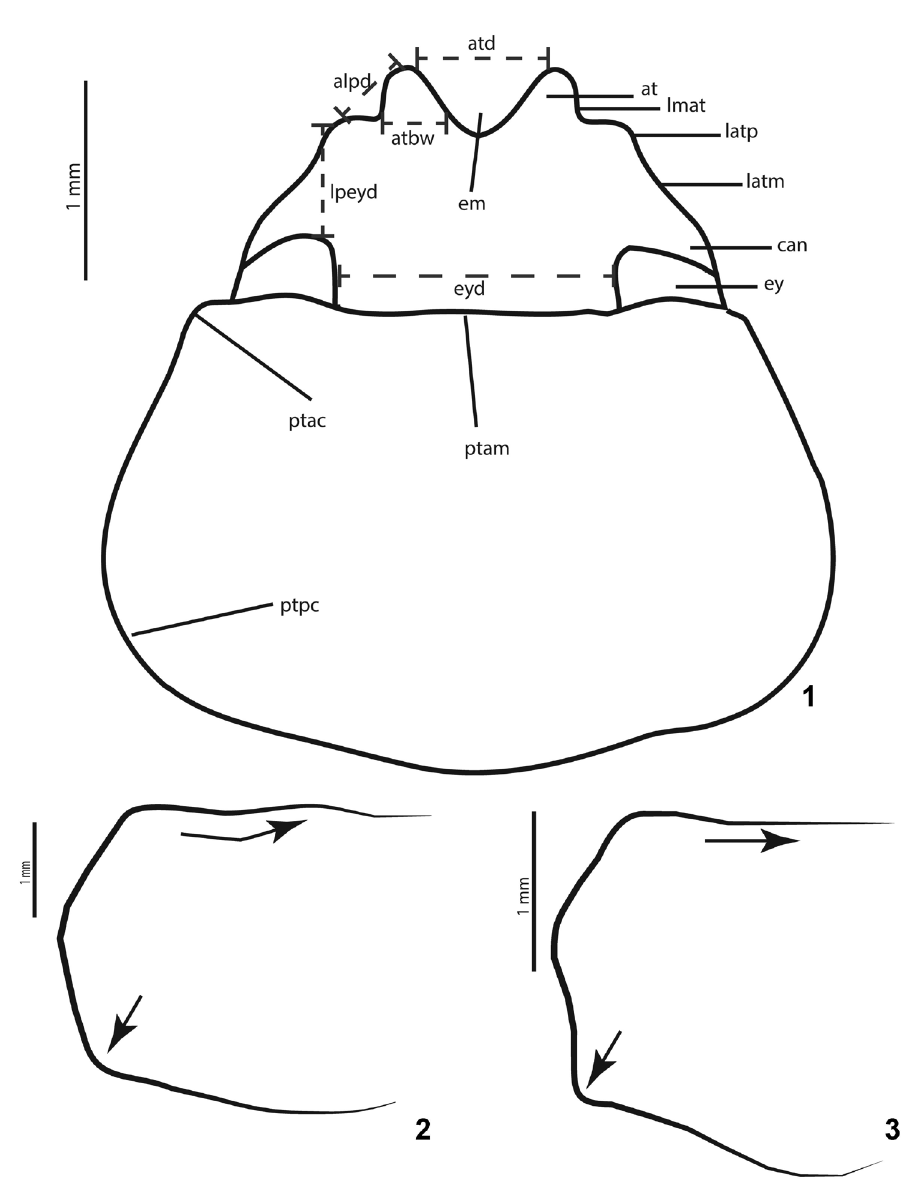
Figures 1–3. Main characters of Liogenys Guerin-Méneville, 1831. 1 Head and pronotum parts, prono- tal posterior corners obsolete 2 Pronotal anterior margin barely produced and posterior corners rounded 3 Pronotal anterior margin straight and posterior corners angled. Abbreviations: alpd= anterior-to-lateral projection distance; at= anterior tooth; atbw= anterior tooth basal width; atd= anterior teeth distance; can= canthus; em= emargination; ey= eye; eyd= eye-to-eye distance; latm= lateral margin of clypeus; latp= lateral projection; lmat= lateral margin of anterior tooth; lpeyd= lateral projection-to-eye distance; ptac= prothorax anterior corner; ptam= prothorax anterior margin; ptpc= prothorax posterior